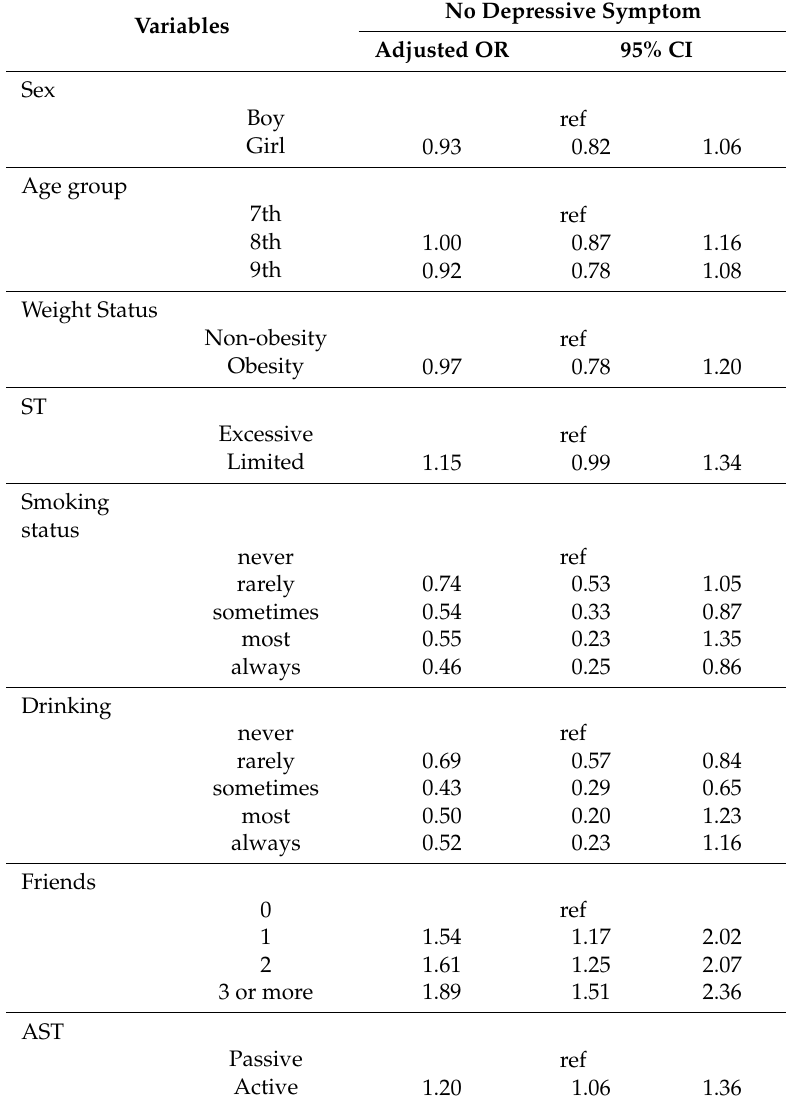
Table 3. Relationships of AST and control variables with no depressive symptom. No Depressive Symptom Variables Adjusted